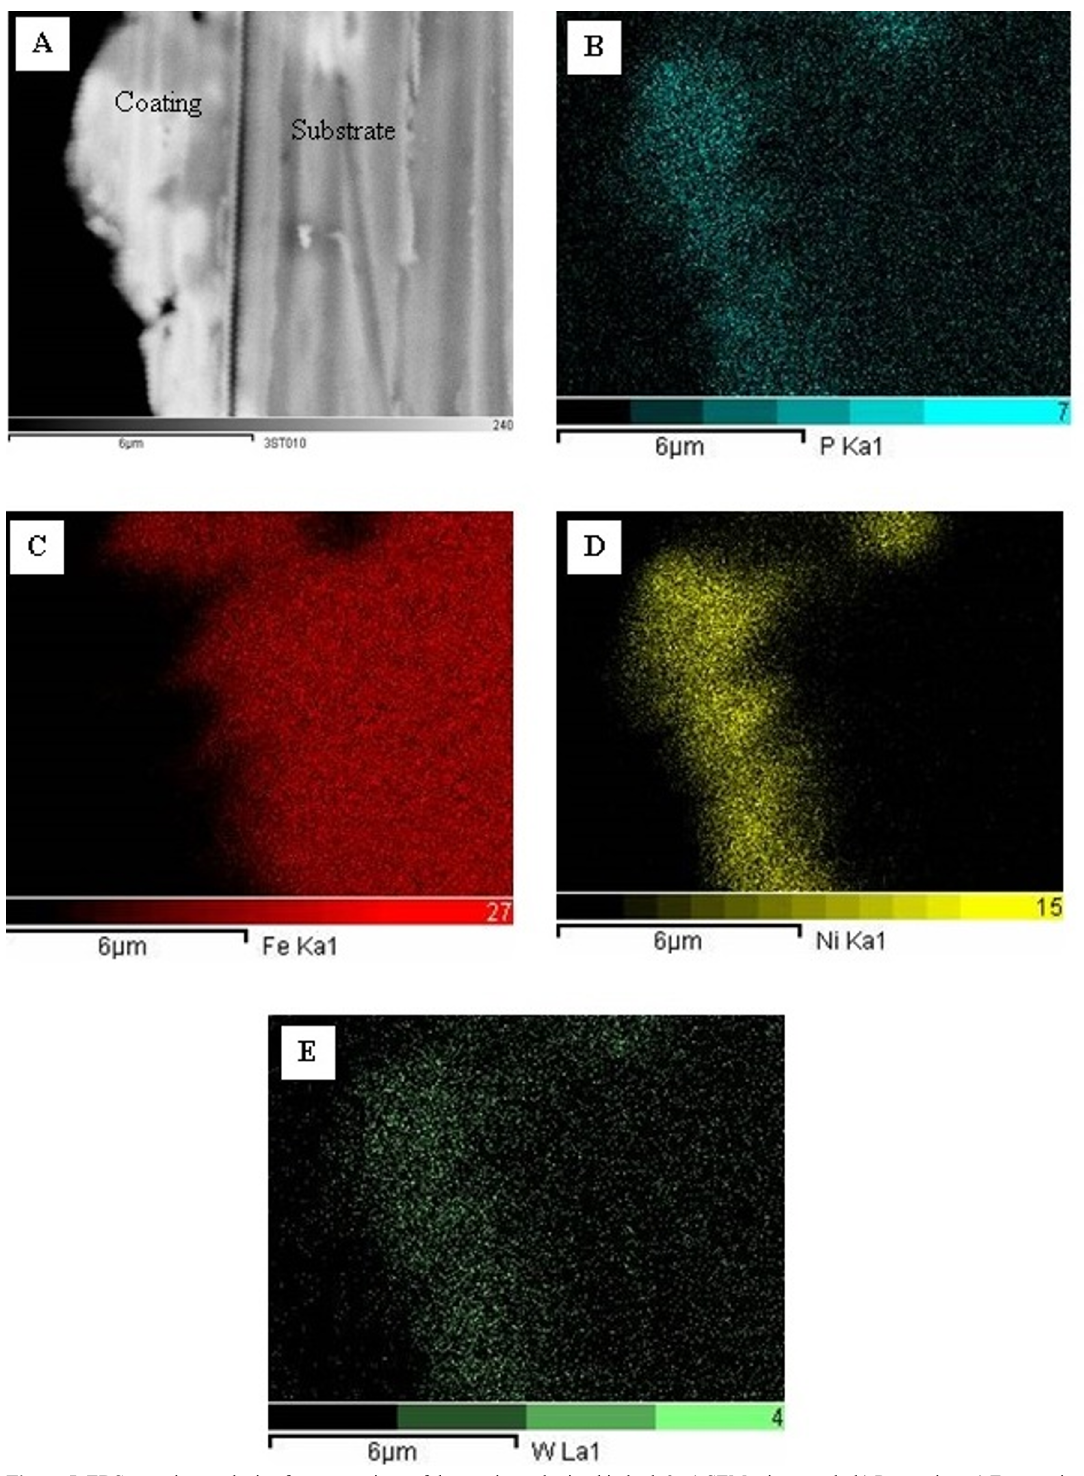
Figure 5. EDS mapping analysis of cross-sections of the coatings obtained in bath 3: a) SEM micrograph; b) P mapping; c) Fe mapping; d) Ni mapping; e) W